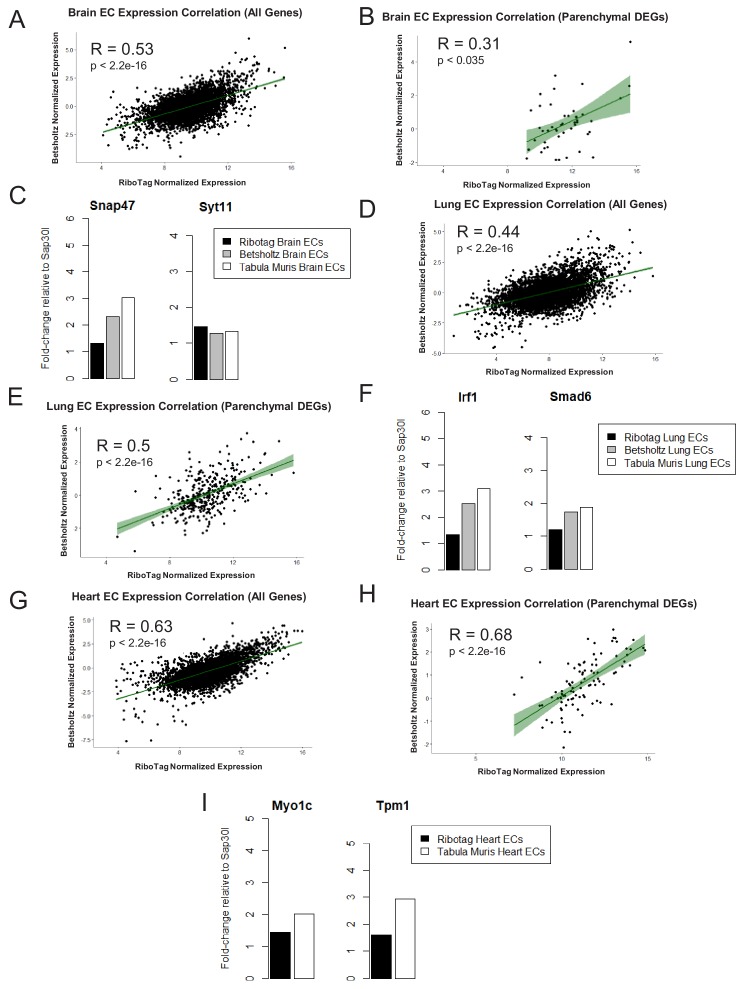
Expression Correlation Analysis between endothelial gene expression generated by RiboTag, Betsholtz, and Tabula Muris Spearman correlation scatter plots of average gene expression in RiboTag bulk RNA-Seq, Betsholtz scRNA-Seq (Smart-Seq2), and Tabula Muris scRNA-Seq (10x Genomics).(A) All genes detected in brain ECs. (B) Parenchymal (non-endothelial) genes detected in brain ECs. (C) All genes detected in lung ECs. (D) Parenchymal (non-endothelial) genes detected in lung ECs. (E) All genes detected in heart ECs. (F) Parenchymal (non-endothelial) genes detected in heart ECs.